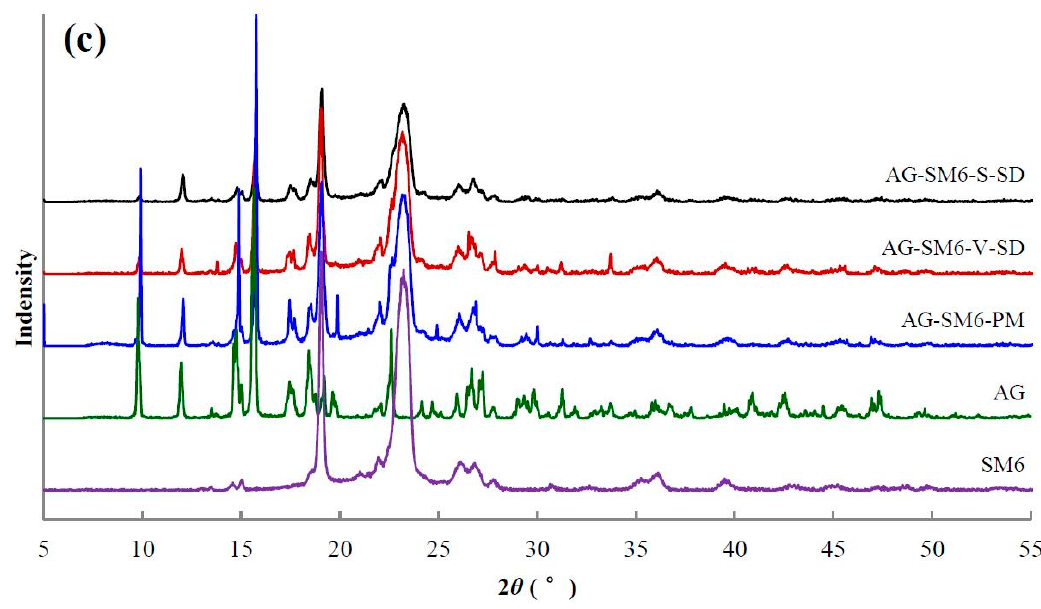
Figure 5. X-ray diffractogram of pure andrographolide (AG), carrier materials, physical mixtures (PM), and solid dispersions (SD): ( a ) PEG4000 as carrier material, ( b ) SM1 as carrier material, ( c ) SM6 as carrier material.